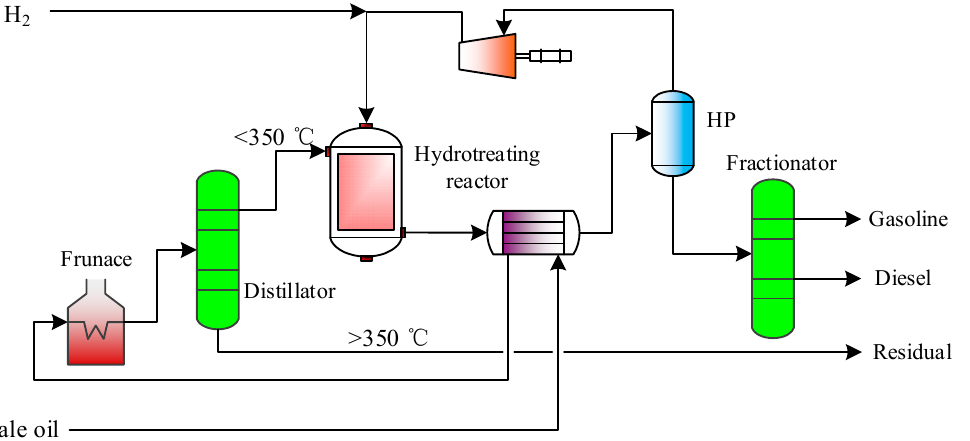
Figure 6. Flow diagram of shale oil light fraction hydrogenation. The flow diagram of shale oil full fraction hydrogenation is shown in Figure 7. Shale